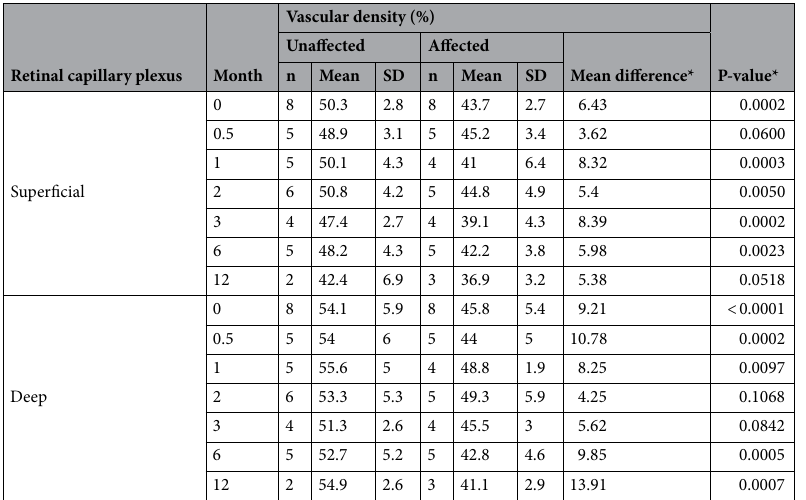
Table 3. Comparison of extralesional vascular density in the superficial and deep capillary plexus between affected and unaffected eyes of unilateral CMVR patients . *Mean differences of vascular density between affected and unaffected eyes and P-value derived from mixed model analysis after adjusting for vitreous haze.